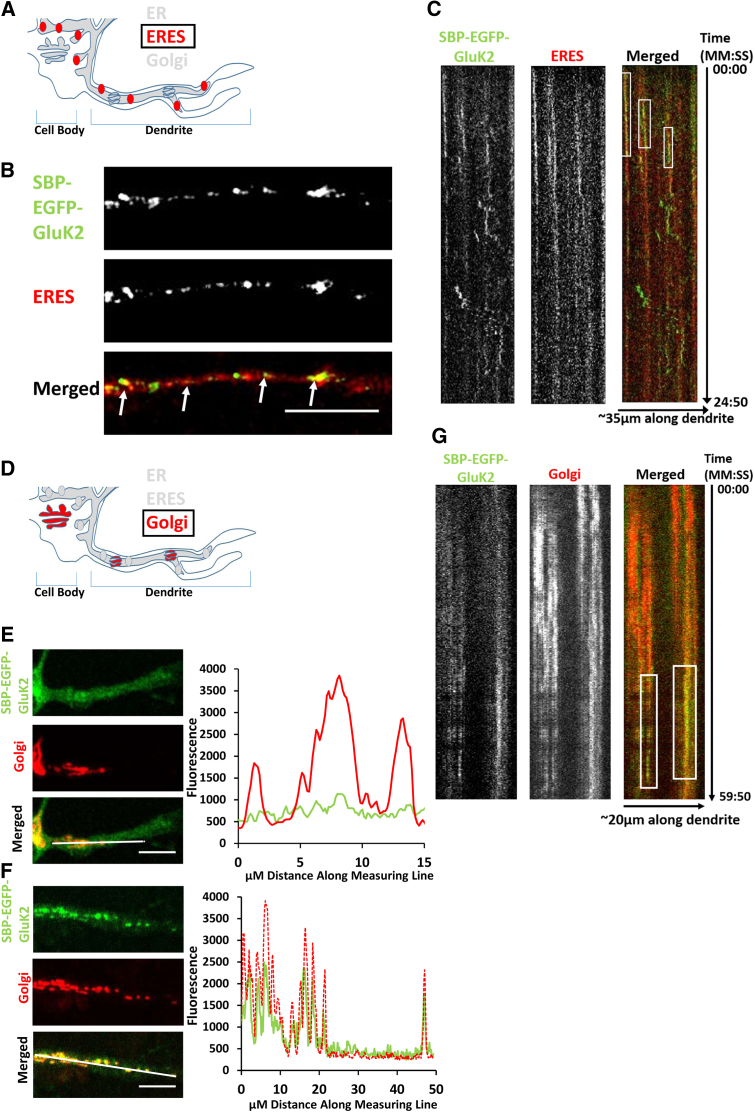
KARs Use Local Secretory Pathway Systems(A) Schematic of dendritic local secretory pathways in neurons, focusing on ER exit sites.(B) Representative fixed confocal images of dendritic ERESs (using the marker mRuby-Sec23a) and SBP-EGFP-GluK2 10 min after biotin addition. White arrows in the merged panel indicate colocalization.(C) Kymograph (Movie S2) of SBP-EGFP-GluK2 and mRuby-Sec23a up to 24 min 50 s after biotin addition, with a frame being taken every 10 s. White boxes on the merged panel show the duration of colocalization.(D) Schematic of dendritic local secretory pathways in neurons, focusing on the Golgi.(E) Representative fixed confocal images of SBP-EGFP-GluK2 colocalization with the Golgi marker Sialyltransferase-mCherry (Golgi) before biotin release and a line trace illustrating lack of colocalization along the line indicated in white in the merged image.(F) Representative fixed confocal images of SBP-EGFP-GluK2 30 min after biotin-induced release with Sialyltransferase-mCherry (Golgi) and line trace quantification.(G) Kymograph (Movie S3) of SBP-EGFP-GluK2 and GalT-mCherry (Golgi) after biotin addition up to 59 min 50 s, with a frame being taken every 10 s. White boxes on the merged panel show colocalization duration.Scale bars, 10 μm.